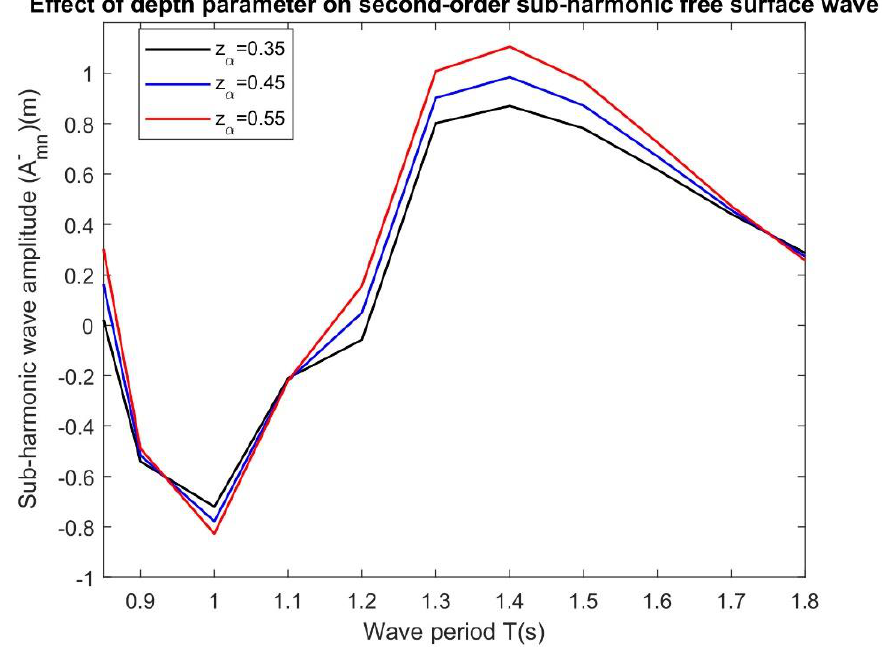
Figure 20. Effects of water depth on second-order sub-harmonic wave amplitude A − mn of Equation (29) at the location B with r = 0.35 m, k m = 0.84 and z α = 0.5.